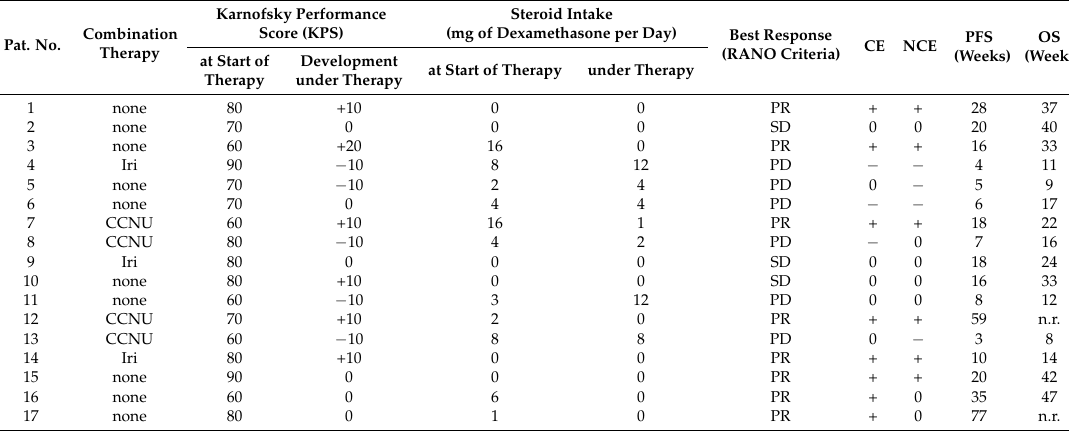
Figure 3. Progression-free (PFS) and overall survival (OS). No significant difference in PFS and OS from patients with a gliomatosis cerebri growth pattern (diffuse) compared to patients with a predominantly solid tumor phenotype (non-diffuse) was observed. Table 1. Outcome of the patients with a diffuse growth pattern.